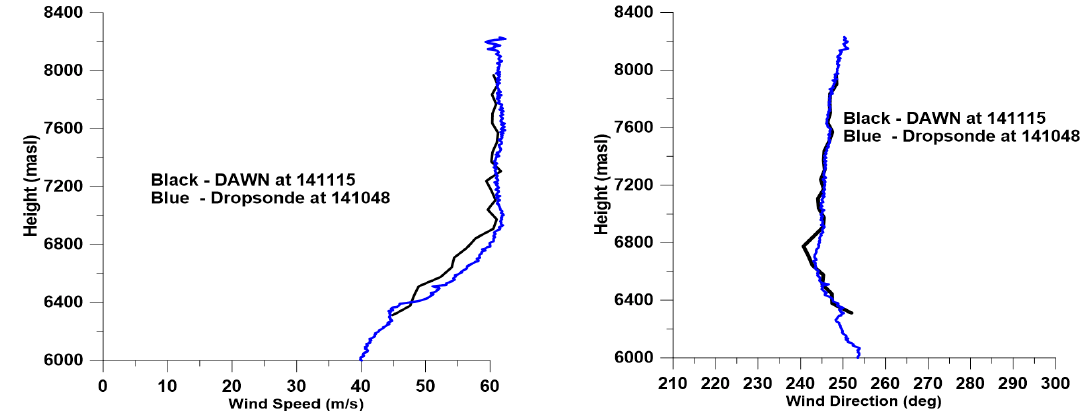
Figure 27. DAWN and dropsonde profiles of wind speed ( left ) and wind direction ( right ) around 1411Z on 19 May 2015.